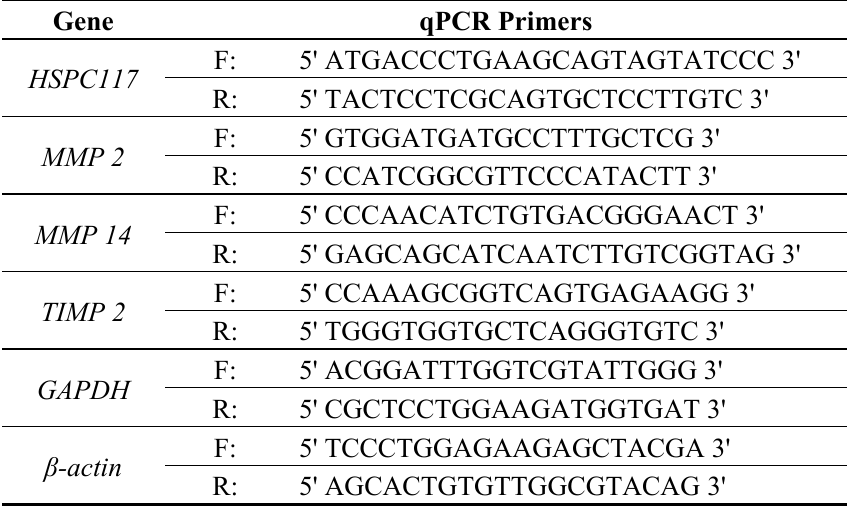
Table 1. Gene-specific quantitative PCR (qPCR)